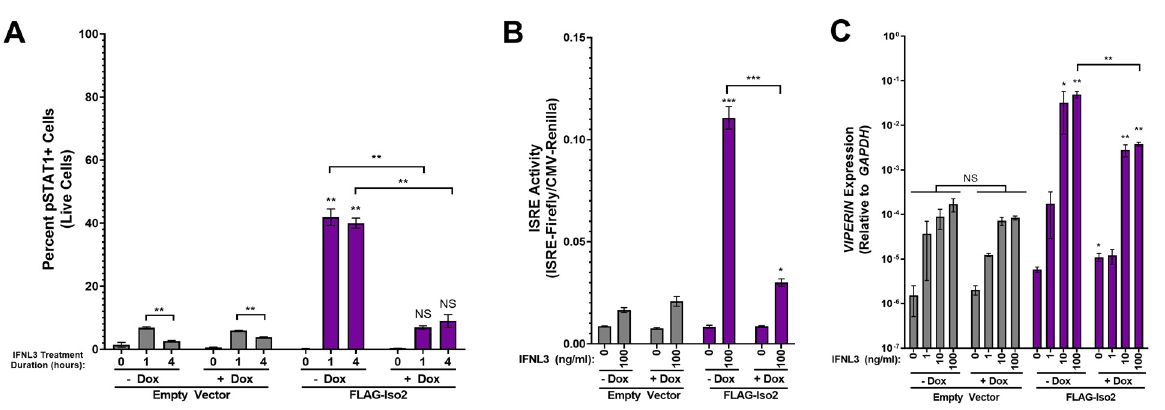
Figure 4. FLAG-Iso2 overexpression differentially influences the cellular response to IFNL3 based on receptor abundance. ( A ) pSTAT1 (two independent experiments), ( B ) ISRE activity (five independent experiments), and ( C ) VIPERIN expression (three independent experiments) were analyzed as described in Figure 3. Statistical significance represented by lone asterisks reflect comparisons between identically treated EV and FLAG-Iso2 cells. Statistical significance represented by bars and asterisks reflect comparisons between − dox and +dox conditions within each cell line. Error bars represent standard error of the mean. * = p < 0.05, ** = p < 0.01, *** = p < 0.001. NS = not significant.